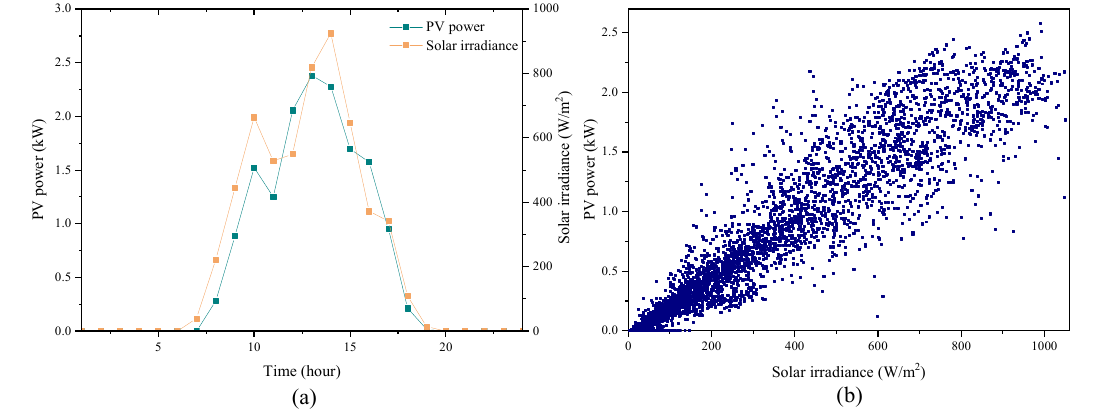
H ou r ( h ) Figure 5. Hourly PV power distribution in 2018. 4.1. Correlation between Photovoltaic Power Generation and Input Variables For a PV power forecasting model, the predicting performance mainly depends on the selection of input variables, which is accessed through a correlation calculation be- tween input and output variables. Therefore, the relevancy between various meteorolog- ical factors, such as solar irradiation, wind speed, precipitation, temperature and relative humidity, with PV power generation is essential for PV power forecasting. Moreover, as the similar days are inserted into the forecasting model, the correlations of PV power in similar days and predicted days are analyzed simultaneously. The correlation analysis is presented by PCC. The strongly related input variables are selected as input vectors. On the contrary, the weakly correlated input vectors are abandoned.